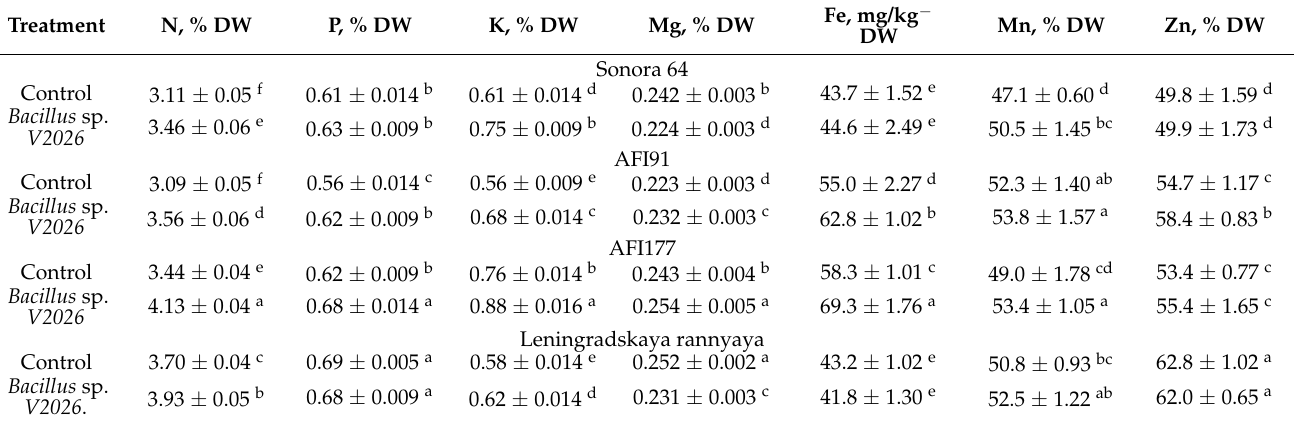
Control, noninoculated wheat plants; Bacillus sp. V2026 , wheat plants inoculated with Bacillus sp. V2026 ; DW, dry weight. Values in columns followed by different letters (a–f) are significantly different at p ≤ 0.05 (Duncan’s